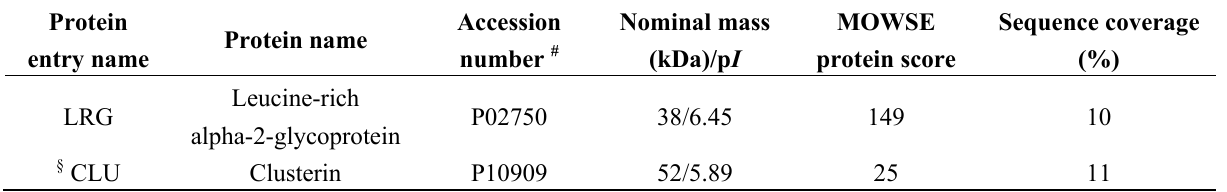
Table 1. Identification of aberrantly excreted urinary O -glycosylated proteins by mass spectrometry (MS).